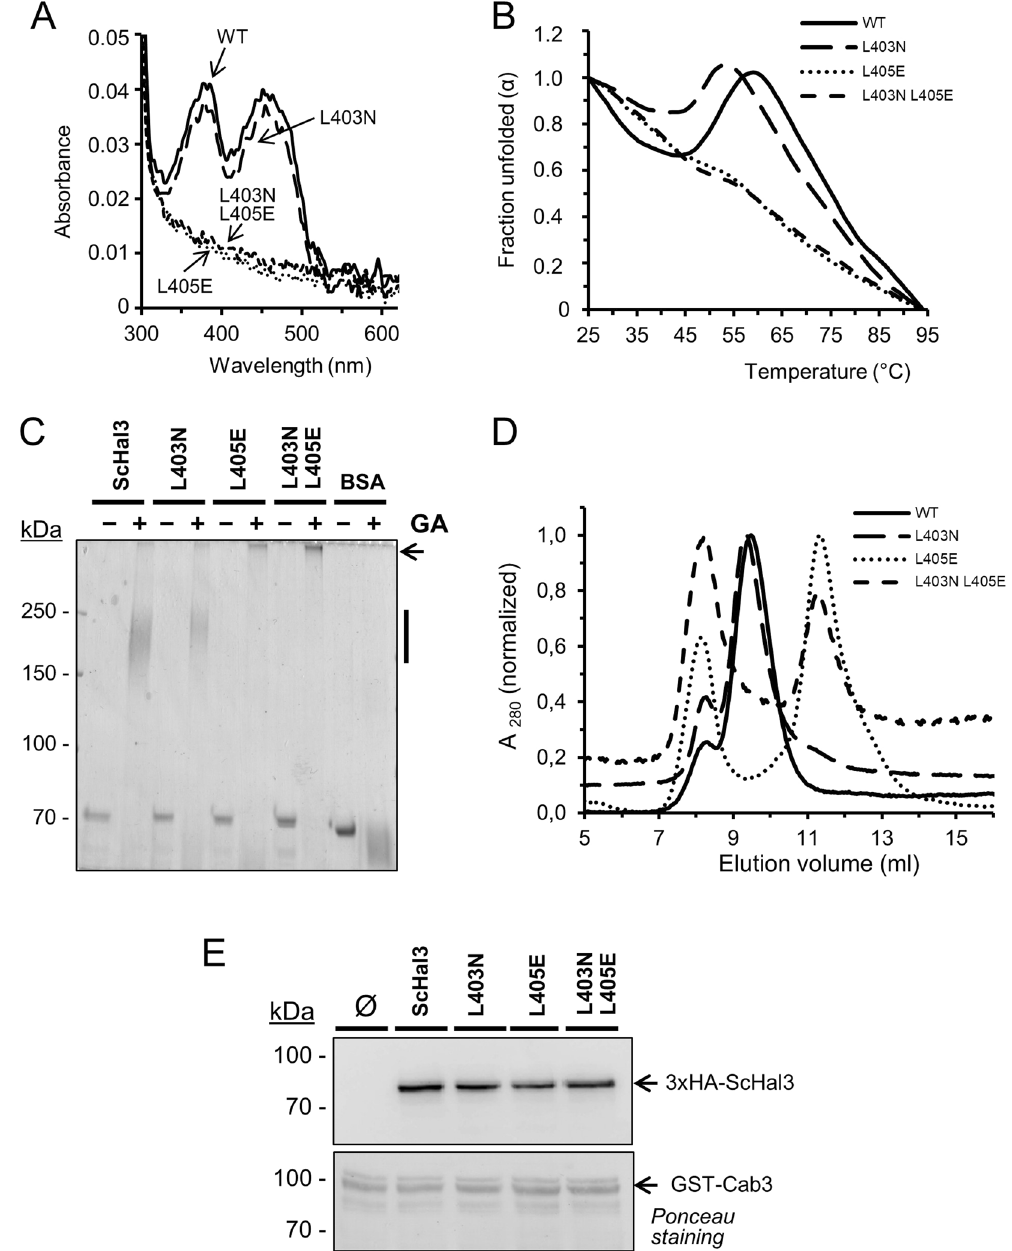
Figure 6. FMN content and trimerization ability of the different ScHal3 variants. ( A ) UV-Visible spectra of the indicated preparations showing the presence or absence of peaks at 382 and 452 nm. WT denotes native ScHal3. ( B ) Temperature-dependent structural stability analysis of ScHal3 variants. The temperature-dependent change in the normalized Trp-derived fluorescence values of native Hal3 and its mutated variants is shown. Wavelengths for excitation and emission were 295 nm and 338 nm, respectively, and the temperature was increased in steps of 2 °C. ( C ) In vitro cross-linking of ScHal3 variants. Samples (2 μ g) were processed as in Fig. 3, resolved by SDS-PAGE (6% polyacrylamide gel) and proteins were visualized by staining with Coomassie Brilliant Blue R-250. The vertical bar on the right denotes the region in which proteins of a MW of ∼ 190 kDa (the predicted size of the homotrimer) is expected, while the arrow indicates the appearance of very high molecular mass structures. ( D ) The indicated samples were subjected to size exclusion chromatography and the A 280 was monitored and normalized in each case to the highest value (taken as the unit) to account for the difference in concentration. ( E ) Ten µ g of GST-Cab3 was immobilized on glutathione-sepharose beads and used as an affinity system to recover HA-tagged ScHal3 versions expressed in IM021 yeast cells. Beads were washed and processed for SDS-PAGE (8% gels) and immunoblotting was carried out using anti-HA antibodies as described in Methods. Ponceau staining of the membranes reveals similar amounts of GST-Cab3 in all lanes. Ø, empty